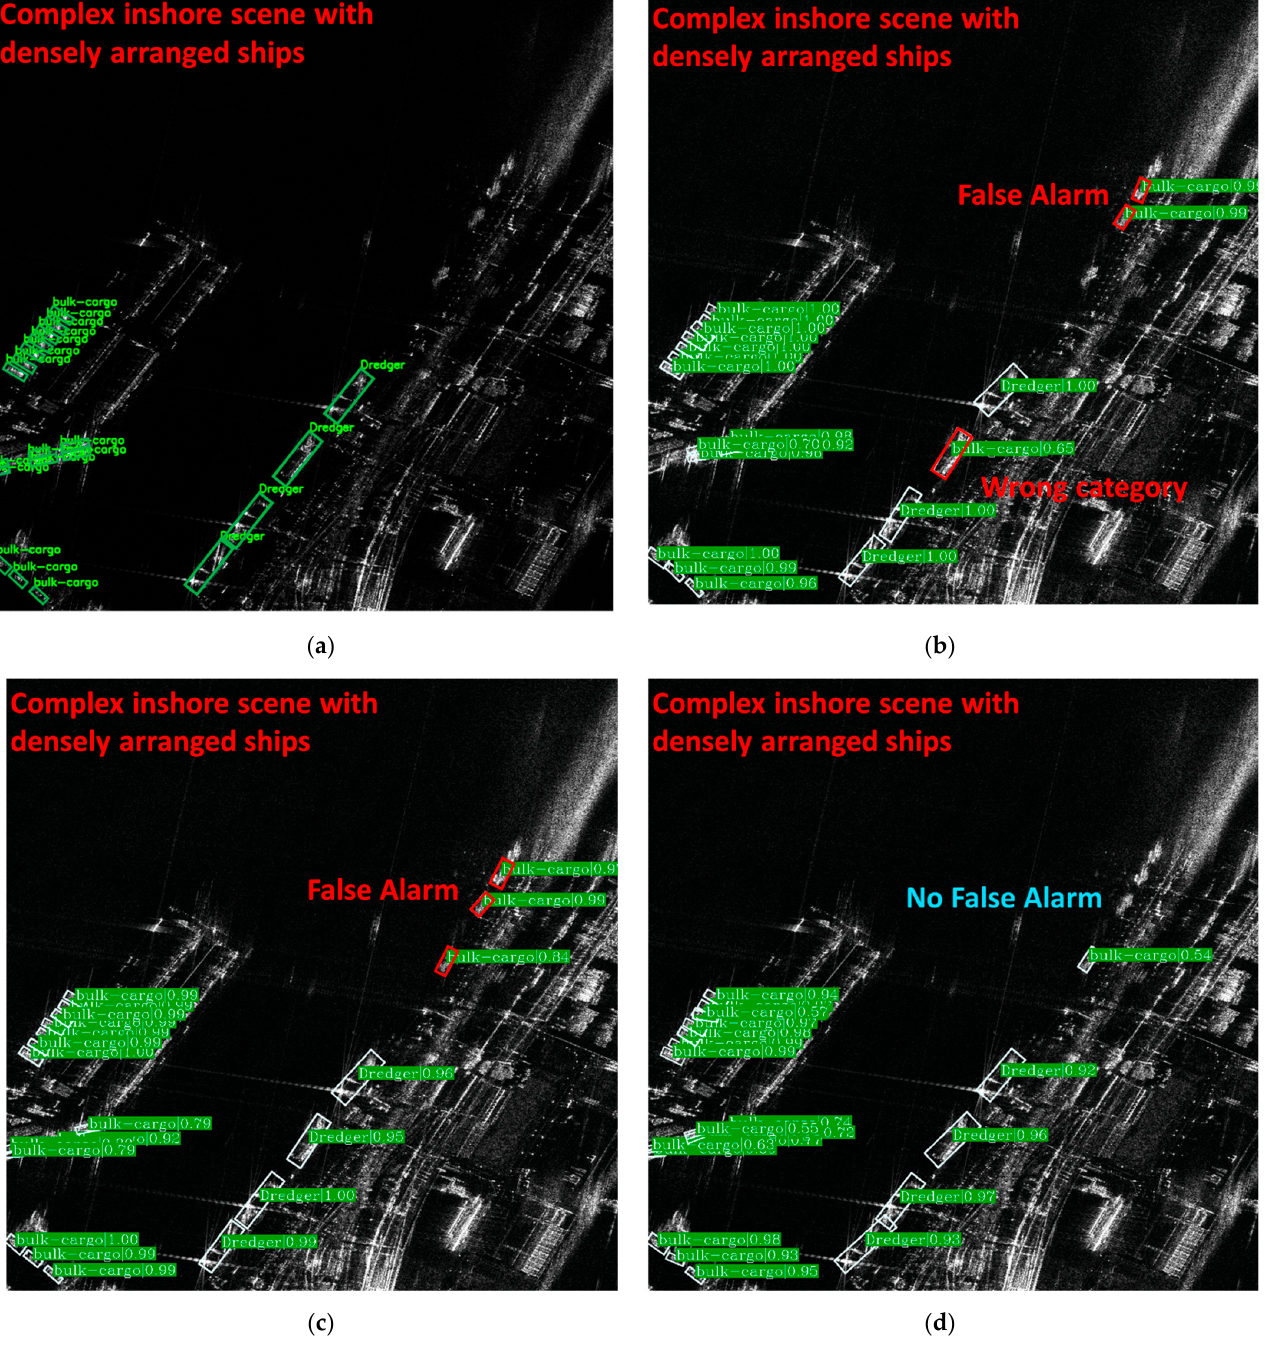
Figure 14. Detection results in densely arranged ship scenes. ( a ) Ground truth; ( b ) Result of ROI; ( c ) Result of O-RCNN; ( d ) Result of RBFA-Net.